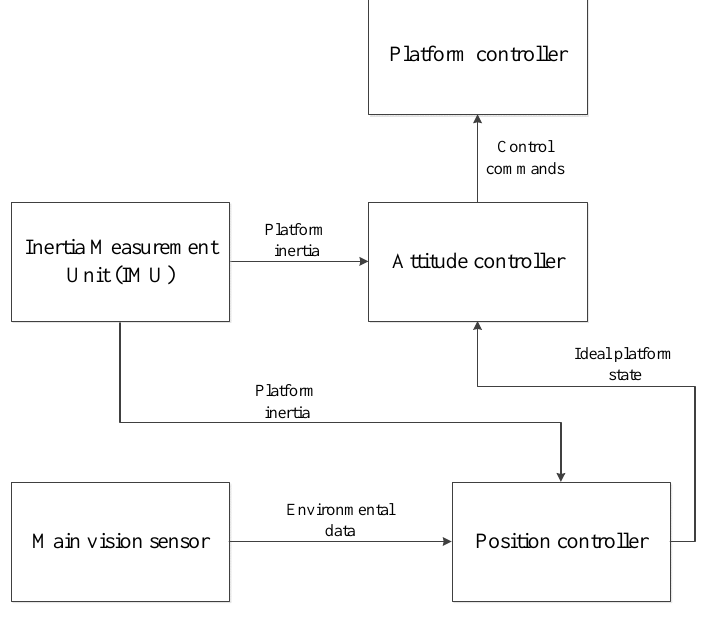
Figure 1. Basic MAV block